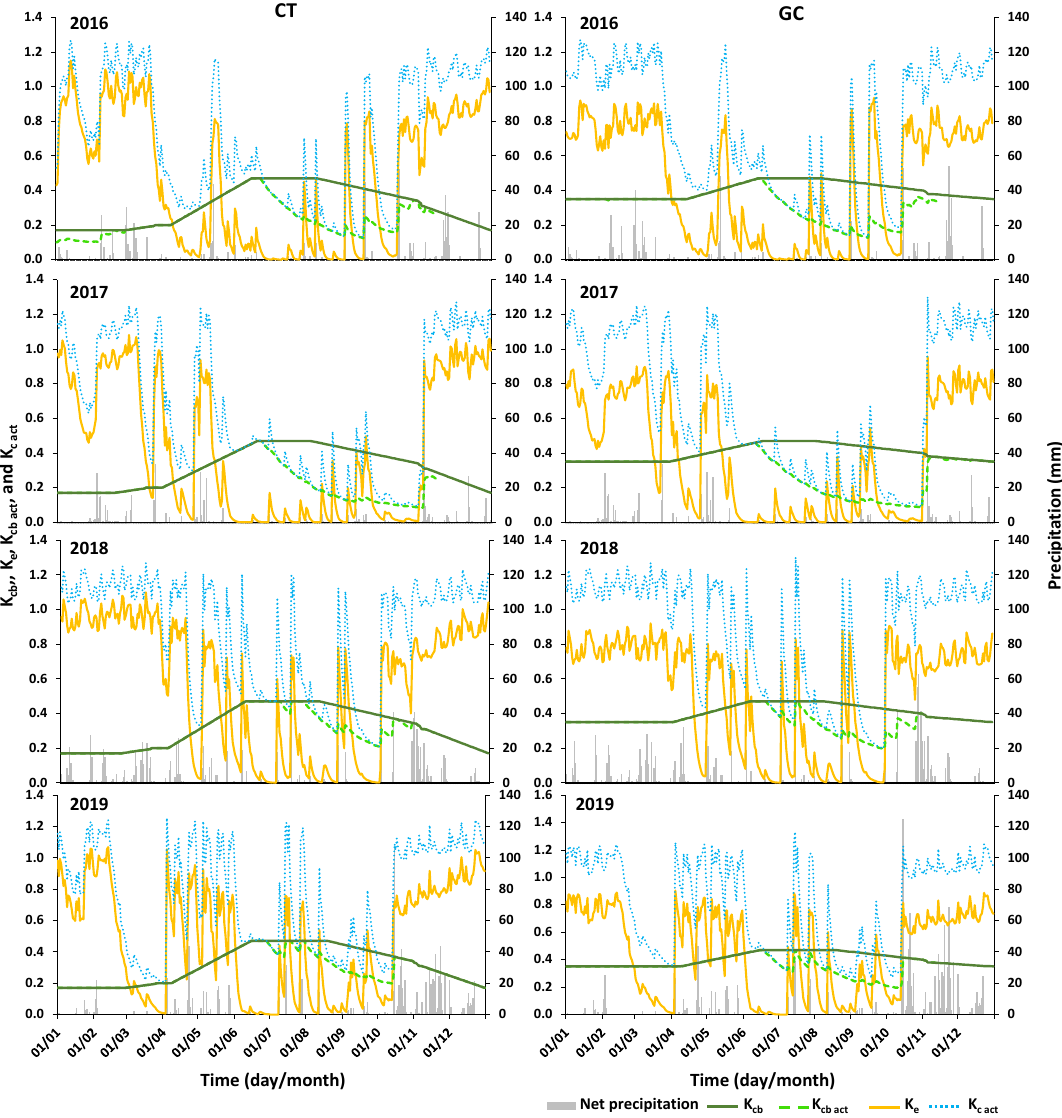
Figure 5. Seasonal evolution of the potential non-stressed basal crop coefficients (K cb ), the actual